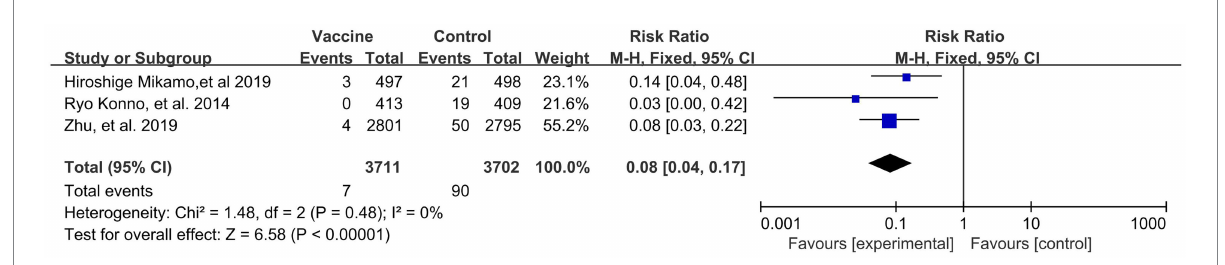
FIGURE 6 A forest plot of the meta-analysis of the incidence of HPV 16/18 associated 12-month persistent infection after HPV vaccination.